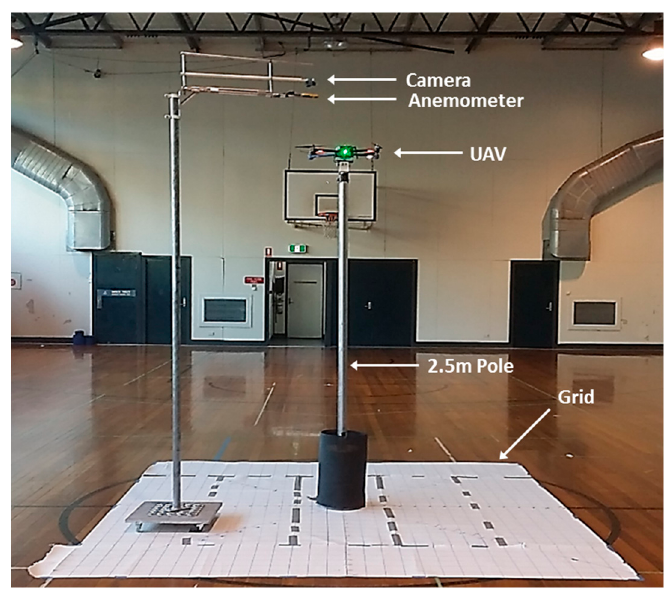
Figure 3. Set up of the multi-rotor UAV and airspeed measuring pole for aerodynamics test.